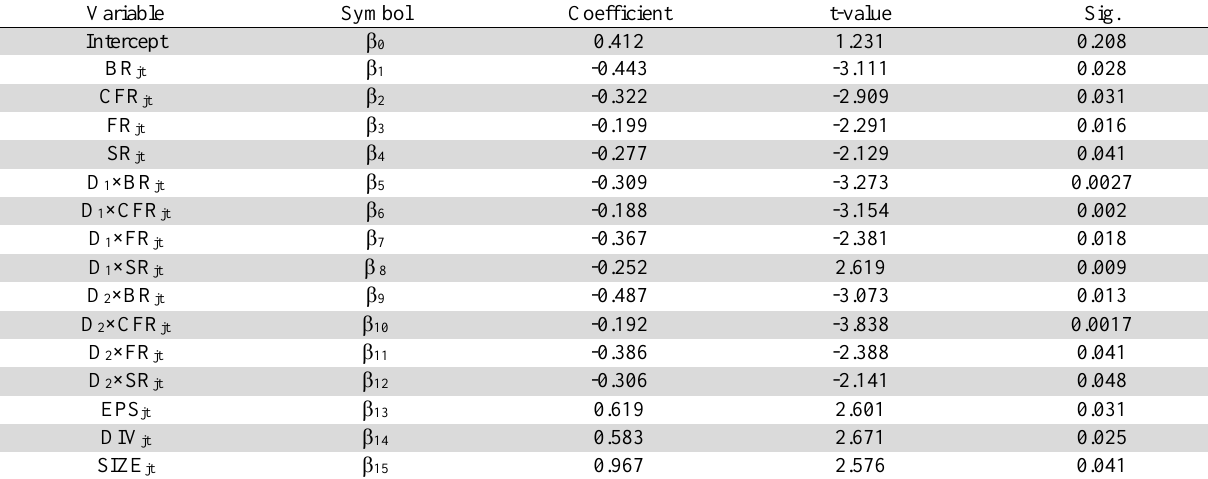
The summary of regression